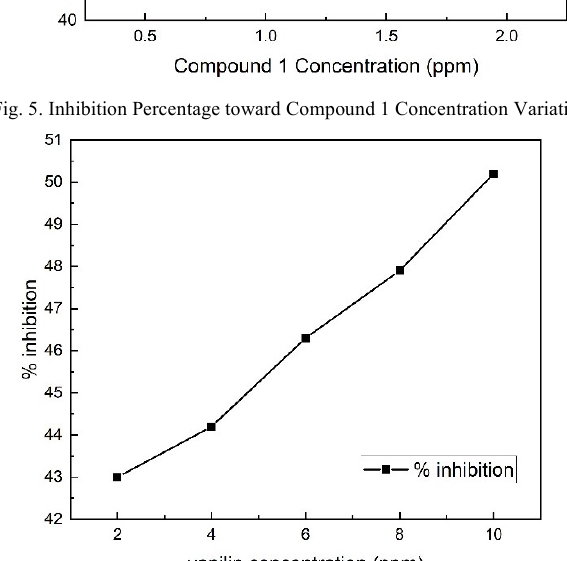
Fig. 6. Inhibition Percentage toward Vanillin Concentration Variation